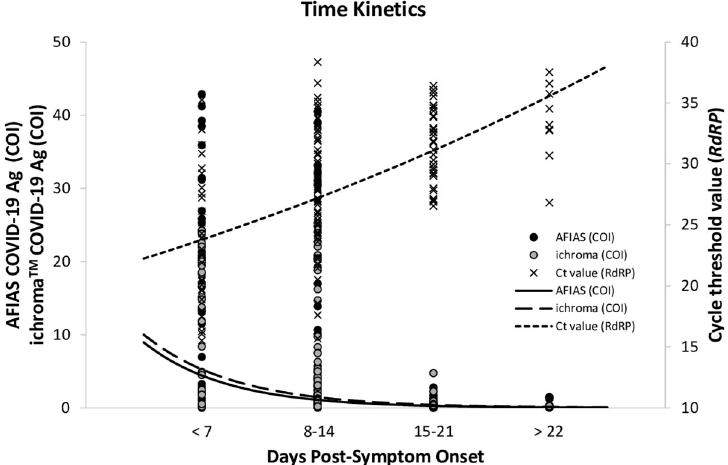
Fig 2. Antigen kinetics determined for specimens from 38 COVID-19 patients at different post-symptom-onset periods assessed by two antigen assays according to cut-off index values, the AFIAS COVID-19 Ag and the ichroma TM COVID-19 Ag. The smoothing splines of both assays showed gradual decrement from the days 1–7 to days > 22, while it was shown that their RdRP gene cyclic threshold values gradually increased or their viral loads decreased. Abbreviations: Ag, antigen; COI, cut-off index; AFIAS, AFIAS COVID-19 Ag (Boditech Med., Chuncheon- si, Gang-won-do, Republic of Korea); ichroma, ichroma TM COVID-19 Ag (Boditech Med.); Ct, cycle threshold.